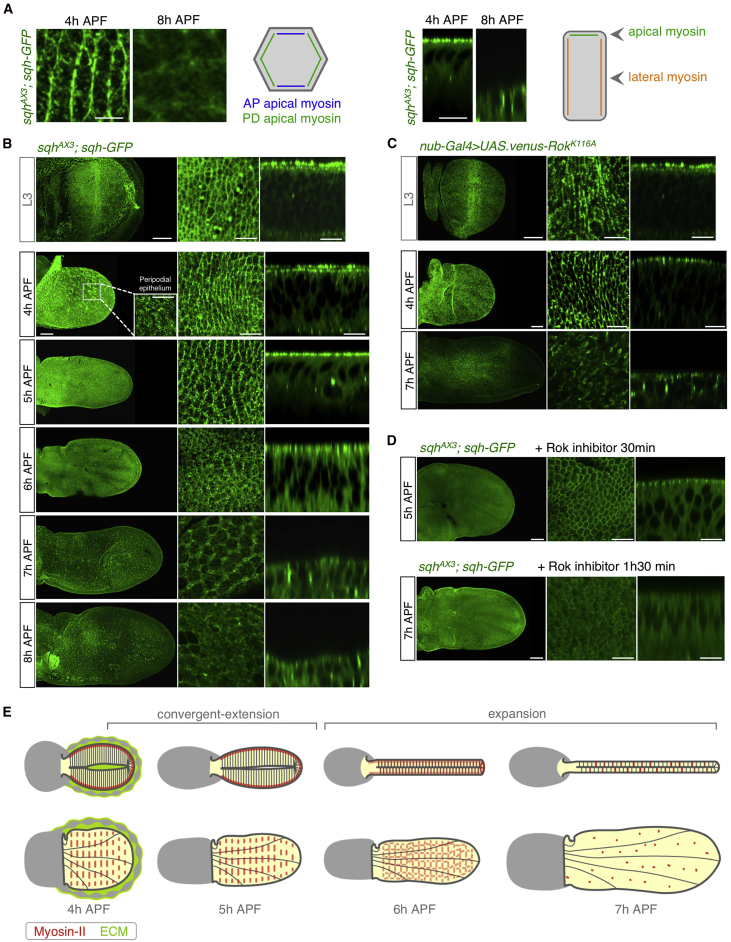
Dynamic Changes in the Localization of Myosin II Drive Convergent Extension and Expansion(A) Apical wing cross-sections at 4 and 8 hr APF (left). At 4 hr APF Myosin II-GFP is planar polarized along the proximal-distal axis, whereas at 8 hr APF is homogenously distributed (see Figure S3A). Lateral wing cross-sections at 4 hr APF and 8 hr APF (right). From 4 to 8 hr APF, Myosin II-GFP relocates from the apical surface to the lateral membranes (see Figure S3B). Scale bar, 10 μm.(B) Myosin II-GFP localization in developing Drosophila wings. Maximum projections (left), high-magnification apical-view xy sections (middle), and lateral-view z sections (right) of sqhAX3; {sqh-GFP} wings are shown. Myosin-II is already polarized along the proximal-distal axis at third instar larval wing discs (L3). During convergent extension Myosin-II-GFP (encoded by sqh-GFP, green) accumulates in apical cables, polarized to drive contraction along the anterior-posterior axis. At 6 hr APF, Myosin-II-GFP starts to relocate the lateral side of the cells, and is strongly localized at the lateral domain from 7 to 8 hr APF. Inset at 4 hr APF shows a high-magnification view of the peripodial membrane, which is subsequently removed. Scale bars, 50 μm (left) and 10 μm (middle and right).(C) Similarly to Myosin-II, Rok-GFP is planar polarized in the imaginal wing disc at late larval stages, but localizes laterally during the expansion phase. Scale bars, 50 μm (left) and 10 μm (middle and right).(D) Treatment of cultured wings with the Rho-kinase inhibitor Y-27632 for 30 min impairs convergence extension and decreases planar polarization of Myosin-II-GFP in 4 hr 30 min APF wings (see Video S7), and cell flattening and wing extension is impaired in 8 hr 30 min APF wings after 1 hr 30 min treatment. Scale bars, 50 μm (left) and 10 μm (middle and right).(E) Schematic diagram of wing disc morphogenesis from 4 to 7 hr APF, in apico-basal (top) and sagittal (bottom) cross-sections. Wing blade is shown in yellow and peripodial membrane in gray. Apical and basal ECM are shown in green, and Myosin-II in red. During convergent extension (from 4 hr to 8 hr APF), Myosin-II is localized apically, planar polarized along the anterior-posterior axis to mediate the elongation of the tissue. During expansion, from 6 hr APF, Myosin-II relocalizes to the lateral membrane, concomitant with the isotropic expansion of the wing and the flattening of the columnar epithelia to a cuboidal one.See also Figures S3 and S4.